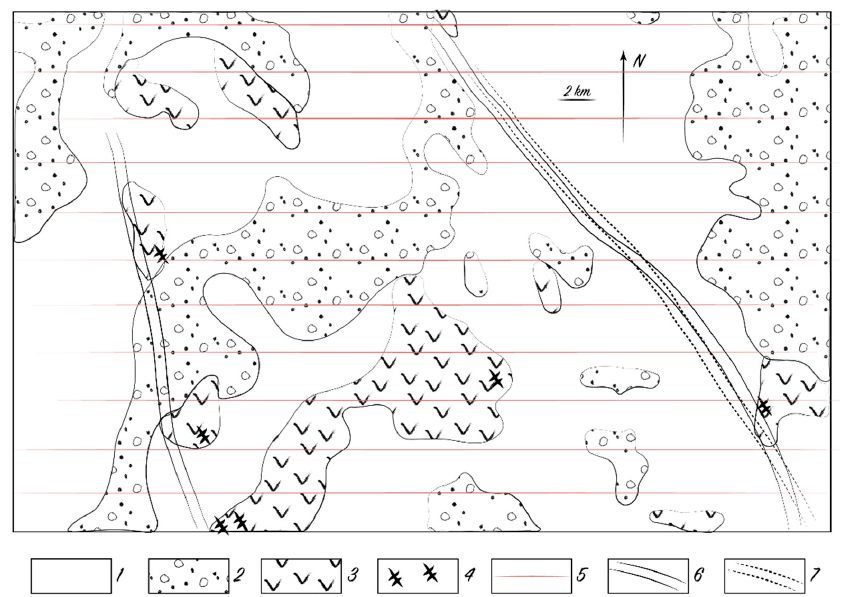
Figure 7. Linear biogeochemical anomalies over the schist-forming zones at the Alkamergenskoe ore field, Kazakh Uplands. Symbols: 1—loose deposits, 5 m thick; 2—Paleogene sandstones and grit- stones; 3—effusive rocks; 4—schist-forming zones; 5—sampling transect lines; 6—Zn biogeochemical anomalies; 7—Mo biogeochemical